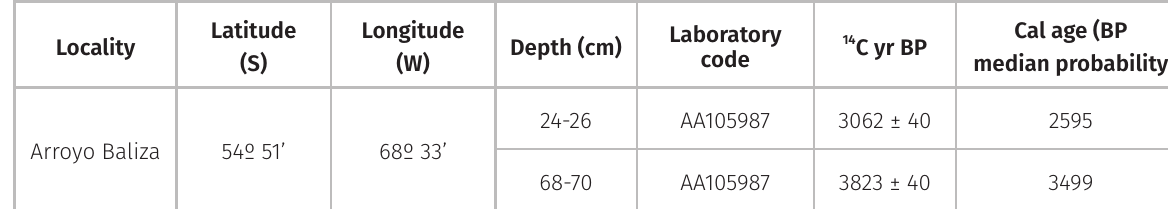
Arroyo Baliza 54º 51’ 68º 33’